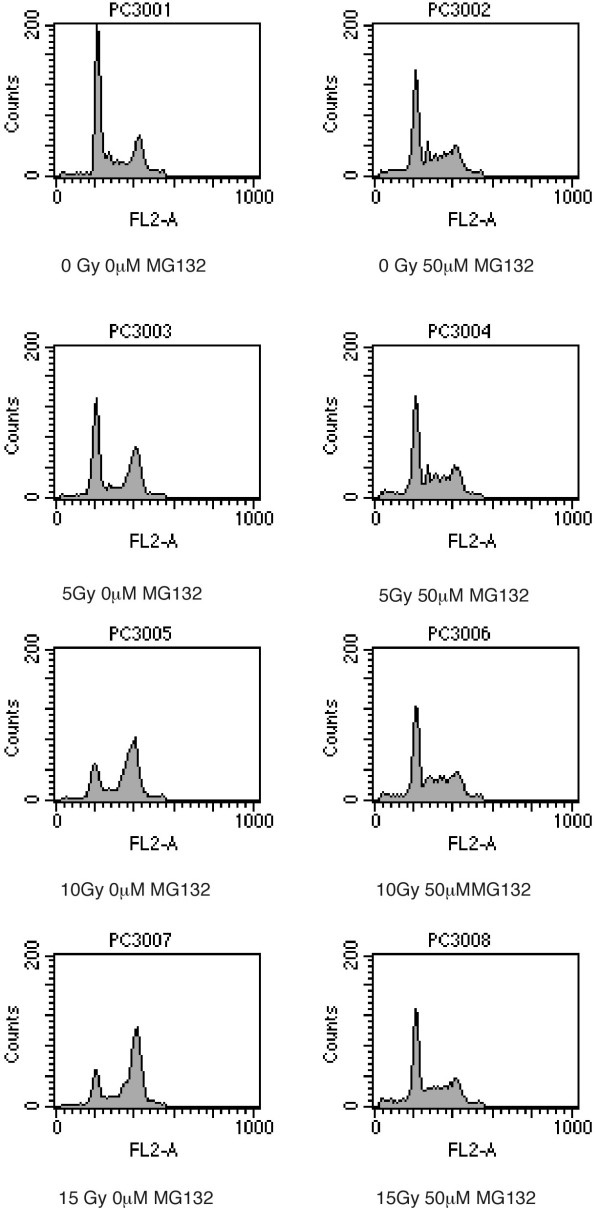
The effect of proteasome inhibition by MG-132 on cell cycle progression and radiation-induced cell cycle arrest and apoptosis. Cell cycle distribution of PC-3 prostate cancer cells assessed by flow cytometry after staining with propidium iodide. Cells were pre-incubated with MG-132 (50 μM) for 3 hours, irradiated, and incubated for additional 24 hours in the presence of MG-132. MG-132 prevented cell cycle progression and, consequently, dose-dependent radiation-induced G2/M-arrest. Additionally, MG-132 treatment increased the number of cells in late S-phase.